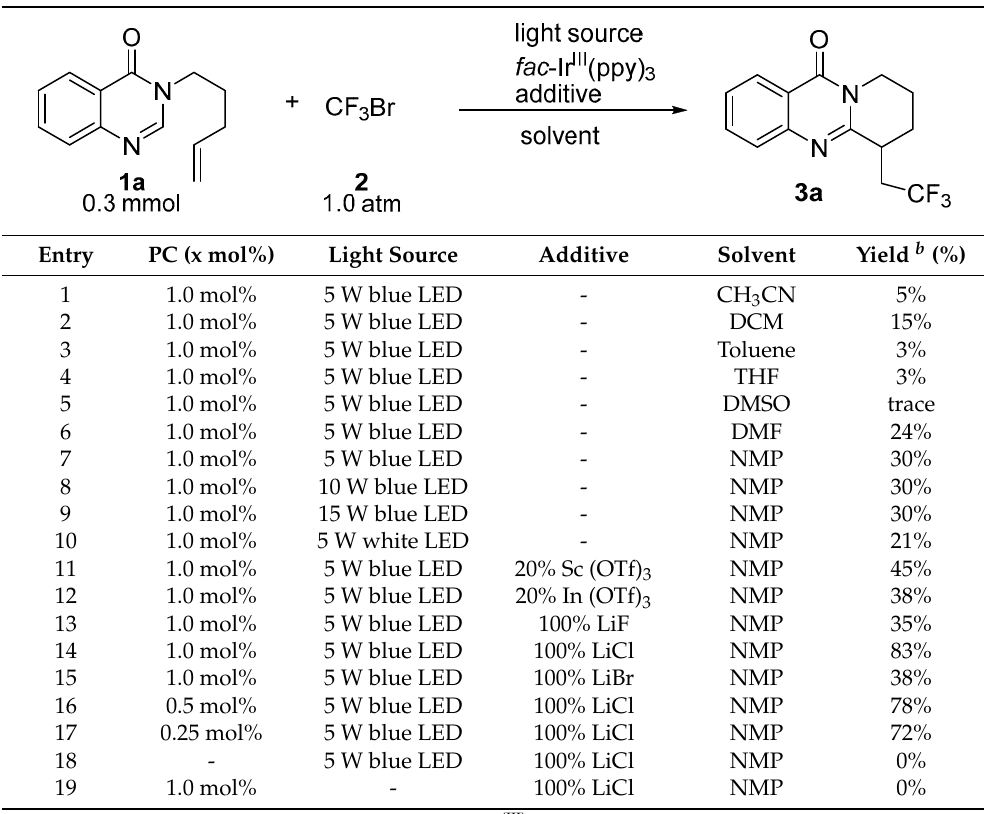
Table 1. Optimization of Reaction Conditions a .